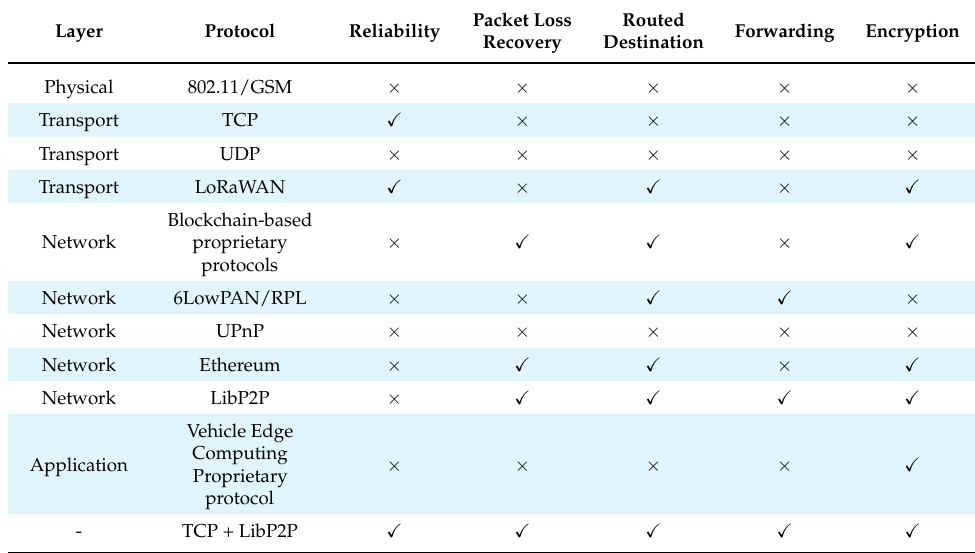
Table 3. Relevant opportunistic features of the protocols of the analyzed state-of-the-art solutions. Layer